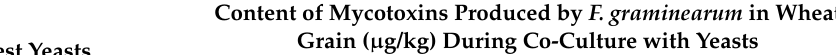
Table 2. Mycotoxin contents in wheat grain after 14 days of incubation (28 °C) of F. graminearum with the test yeasts.